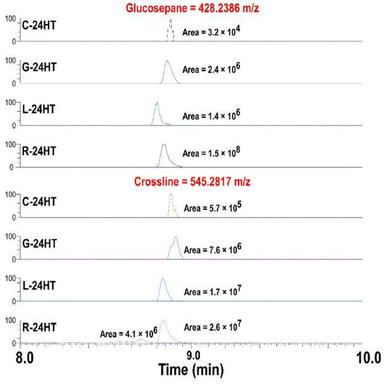
Extracted ion chromatogram (EIC) chromatograms of glucosepane and crossline (428.2386 and 545.2817 m/z, respectively) showing their separation on a Cogent Diamond Hydride column in gelatin films as a function of saccharide (glucose (G), lactose (L), and ribose (R)) and heating time (nonheated (NH), heat-treated (HT) for 2, 6 and 24 h).